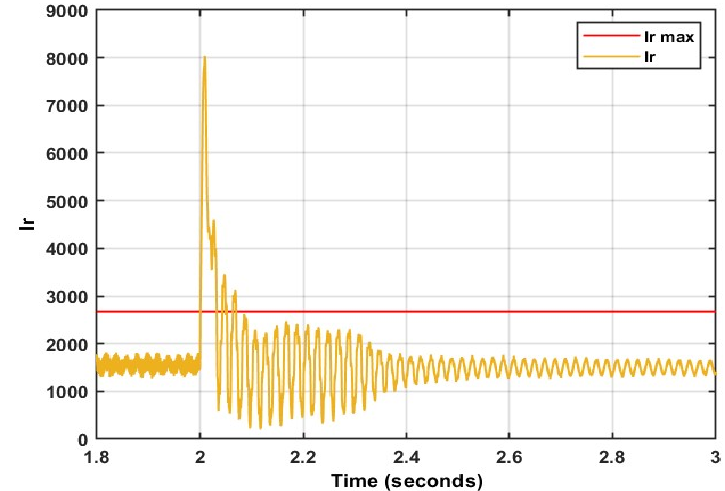
Figure 13. Rotor current transient using PSO at 80% dip.